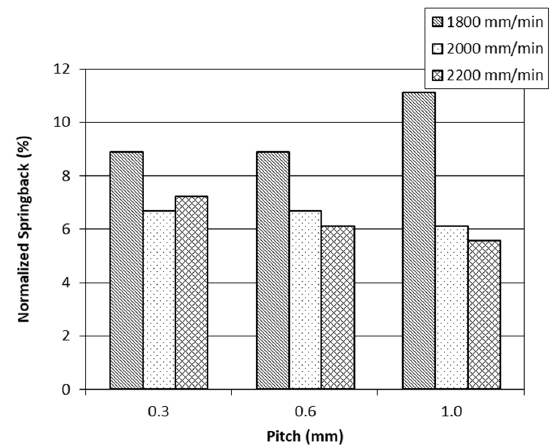
Figure 9. Normalized springback, for different pitches and feed-rates.